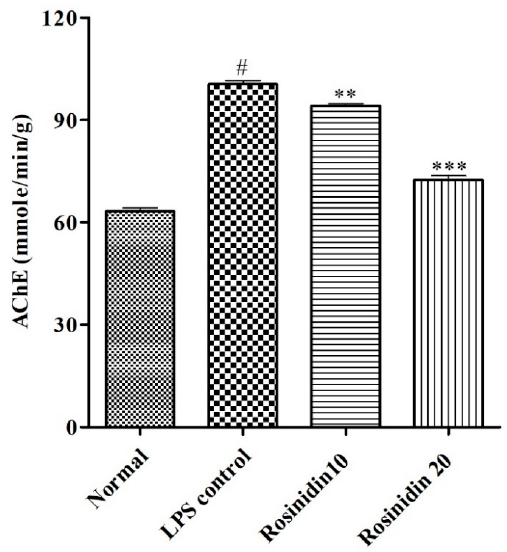
Figure 7. Effect of rosinidin on acetylcholinesterase activity in LPS-treated rats. Values are expressed in mean ± S.E.M. (n = 6). # p < 0.05 vs. normal control rats and ** p < 0.01 and *** p < 0.001 vs. LPS control rats. One-way ANOVA followed by Tukey’s post hoc